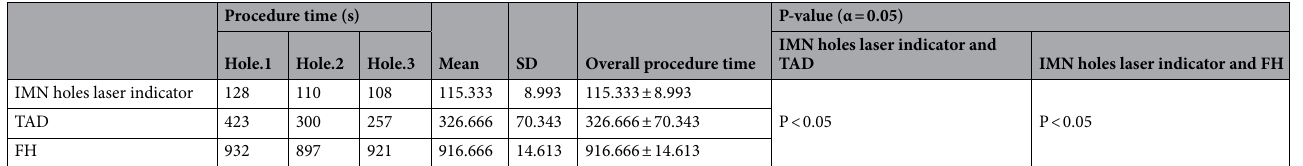
Table 3. The procedure time for each interlocking of IMN hole in the human test using the IMN holes laser indicator, Targeting-Arm Device (TAD), and Free-Hand (FH) techniques.